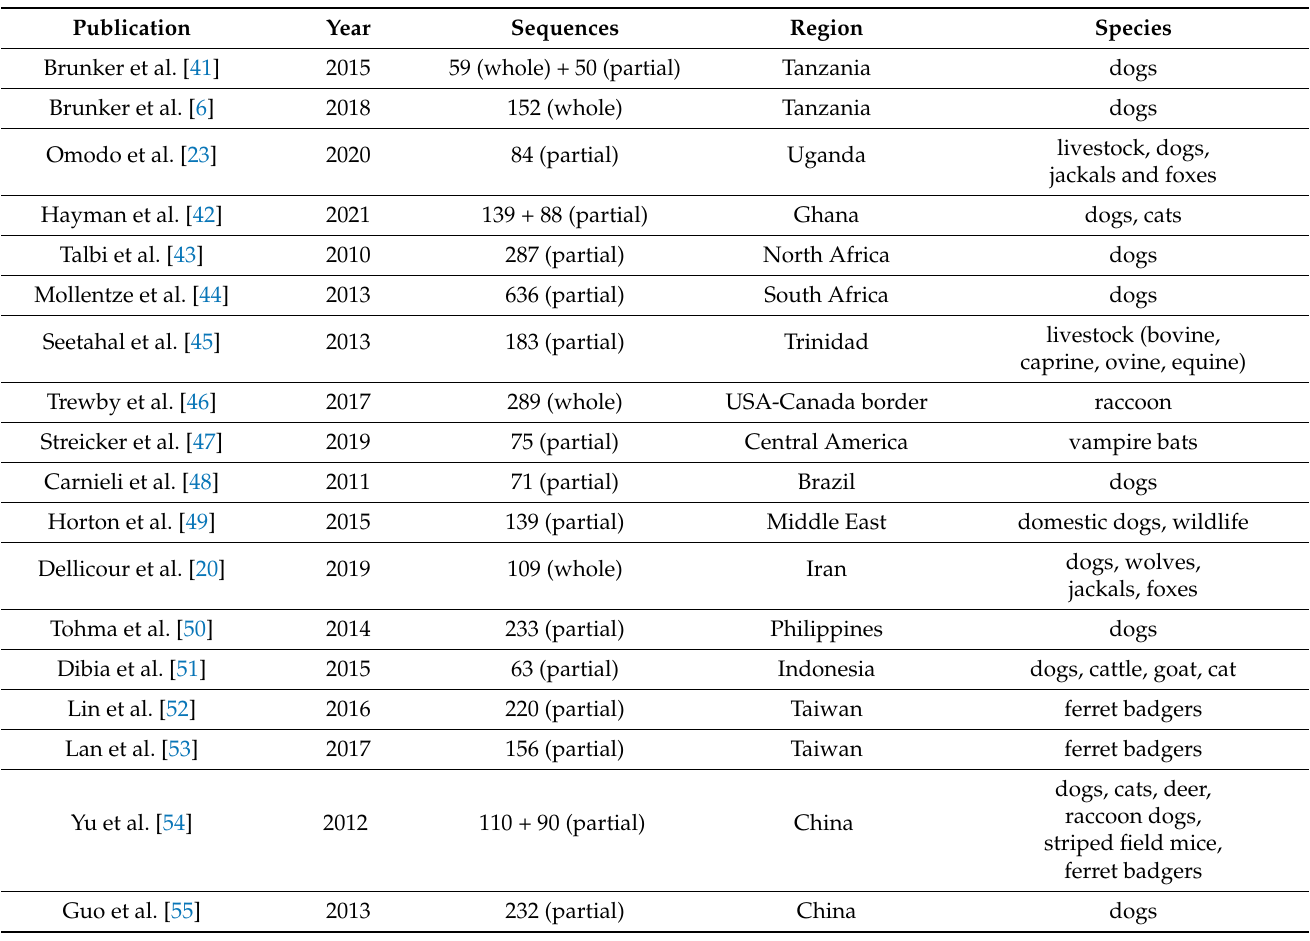
Table 1. Overview of discrete phylogeographic studies on RABV considered. Many of these studies did not have whole- genome sequences at their disposal. Dogs constitute the species of attention in the majority of